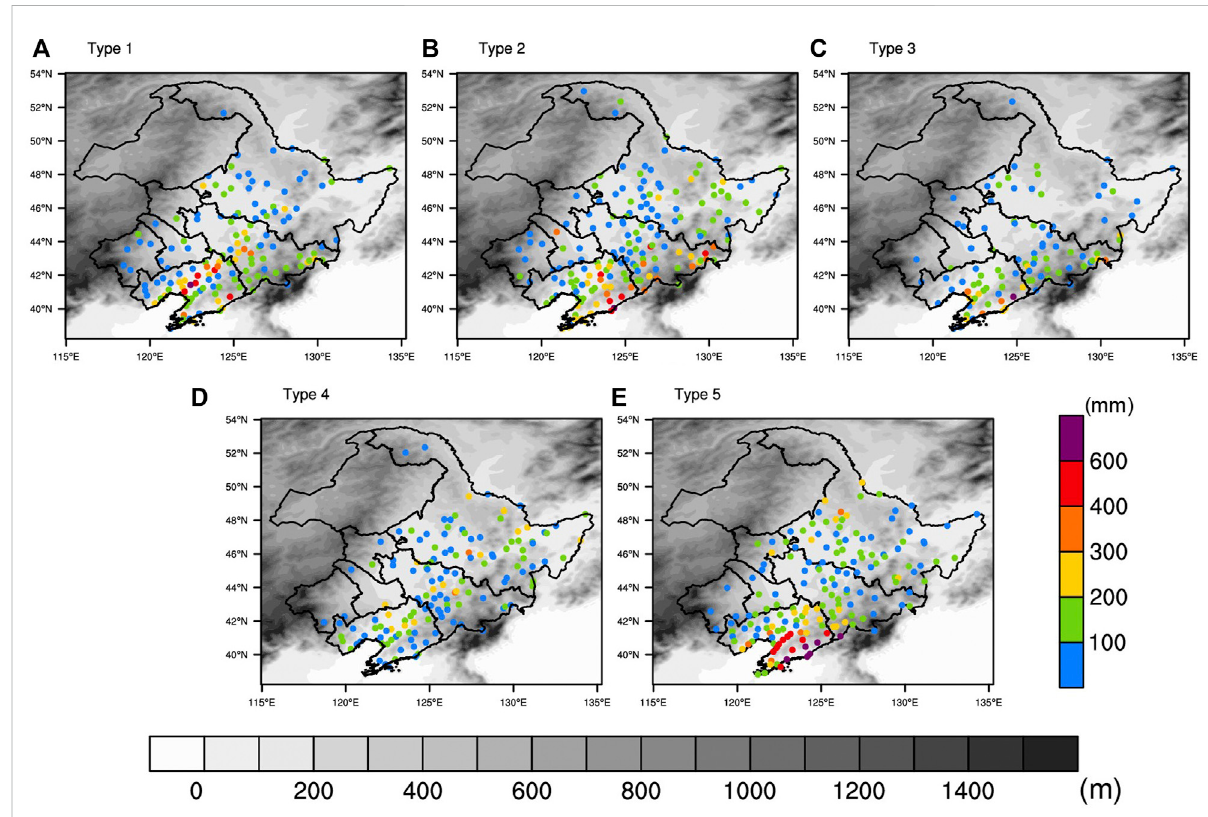
FIGURE 7 Spatial distribution of accumulated precipitation (units: m) of rainstorm days associated with NECVs under fi ve types of synoptic circulation patterns (A-E) in the warm seasons from 2000 to 2019, superimposed with topographic height (units: